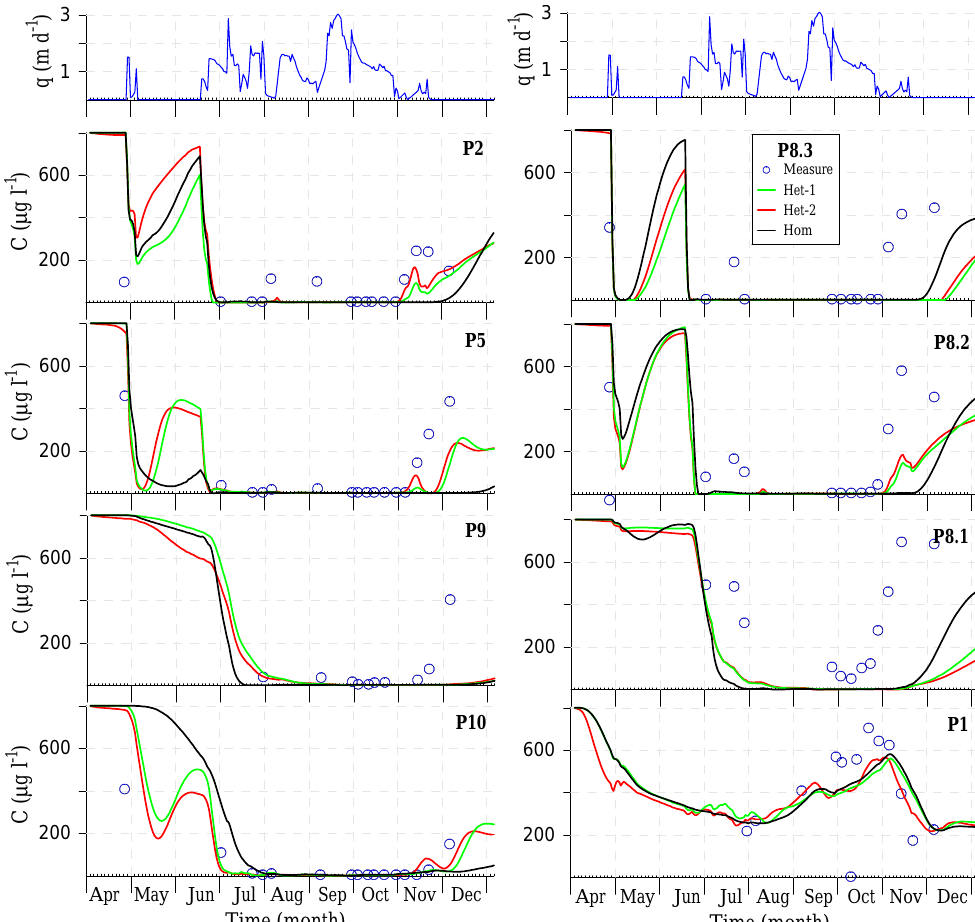
Figure 5. Measured (dark blue circles) and calculated TCA concentration (µgL − 1 ) changes over time at monitoring piezometers for the Het-1 (green line), Het-2 (red line), and Hom (black line) models. The infiltration rate is also shown